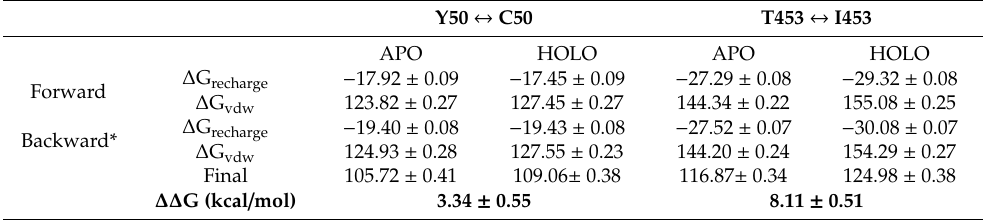
Table 4. Wild type EthA-FADH2-NADP-ETH complex is more stable than mutant complexes. TI outcomes for forward and backward paths in the two-step approach to determining the free energy change ( ∆∆ G = ∆ G HOLO − ∆ G APO ) for Y50C and